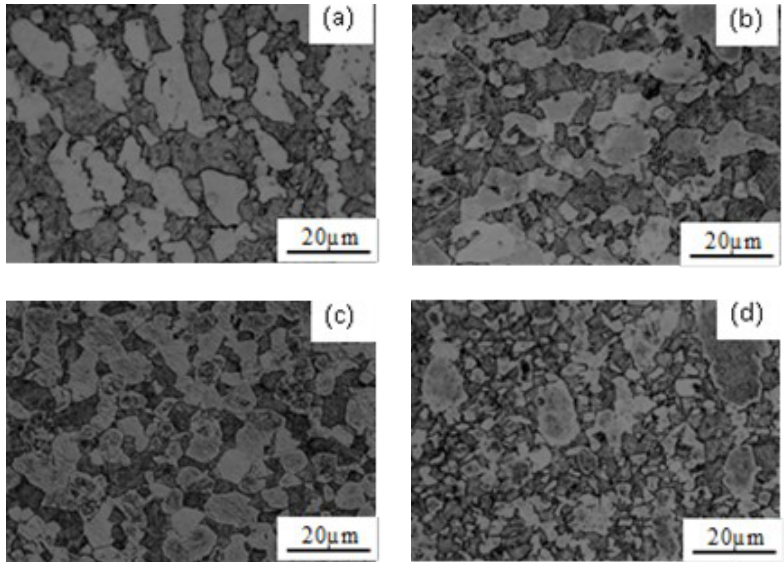
Figure 7. Microstructures of the TC4 alloy deformed at different strain rates (T = 860 °C). ( a ) 5 × 10 −4 s − 1 ; ( b ) 10 − 3 s − 1 ; ( c ) 5 × 10 − 3 s − 1 ; ( d ) 5 × 10 − 2 s − 1.